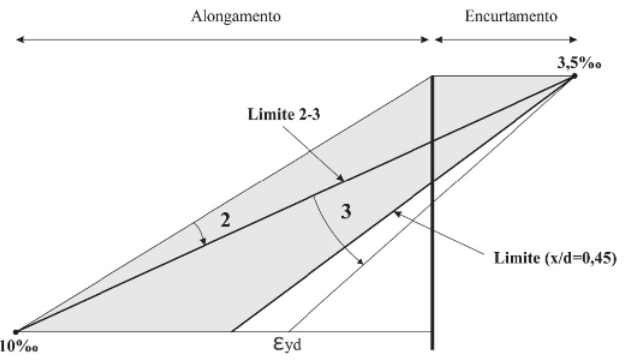
na Figura 7. Para as seções otimizadas, foram obtidos os domínios de de- formação (domínio 2 ou 3) e a deformação dos materiais (aço e concreto). Tais informações são apresentadas nas Figura 8 e Tabela 3.